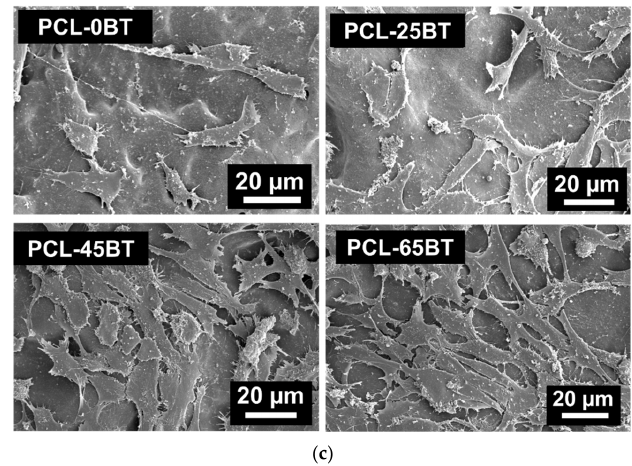
Figure 11. Effect of BaTiO 3 content on the in vitro properties of the piezoelectric scaffolds. ( a ) OD readings of the MC3T3 cells cultured on the PCL and various piezoelectric PCL-BT scaffolds; 1 MHz US were used per the routine for all the proliferation test. * means statistically significant ( p < 0.05) with respect to PCL specimens. # means statistically significant ( p < 0.05) with respect to the specimens in the “3 days” group. SEM images of the adhered MC3T3 cells on various scaffolds ( b ) after day 1 and ( c ) after day 7 of culture.